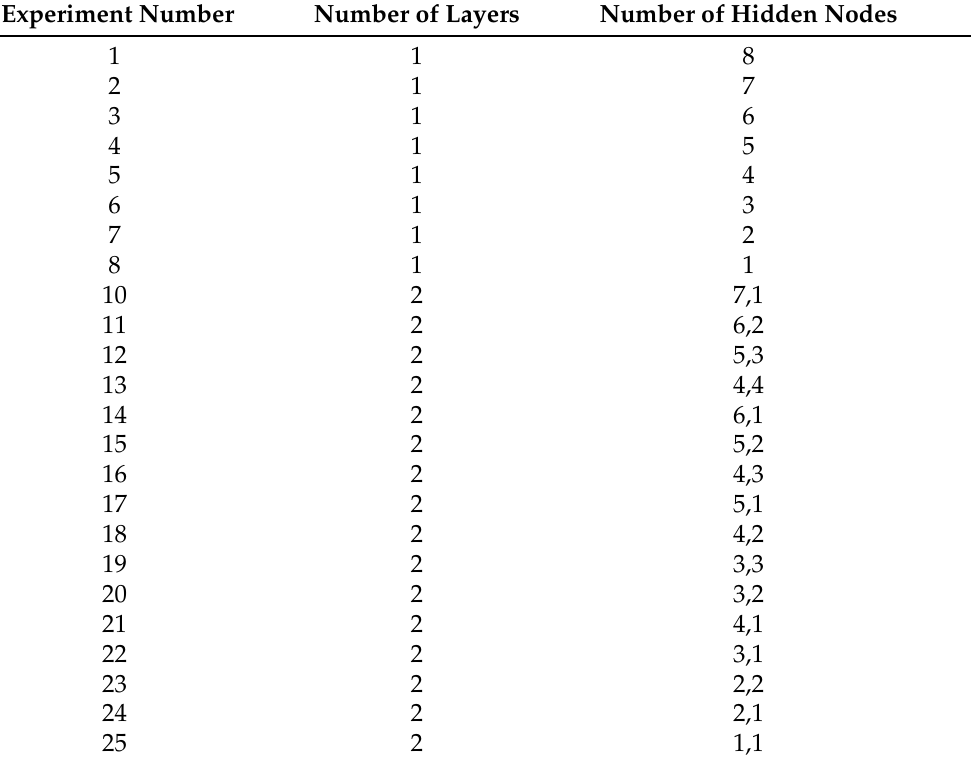
Table 4. Experiments specifications.